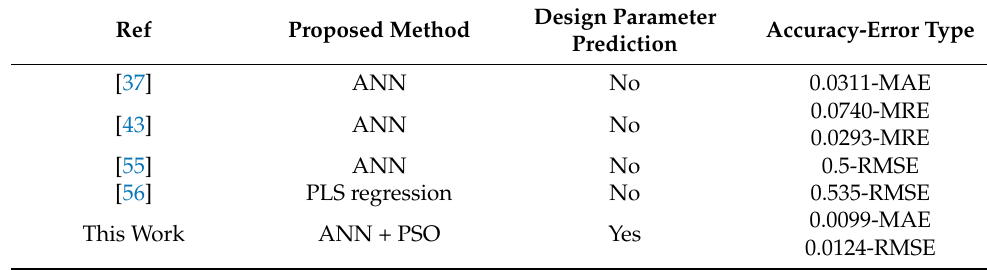
Table 9. A comparison between the performance of proposed algorithm and other research